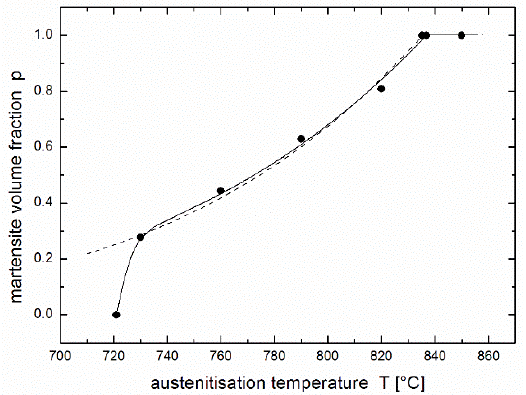
Figure 9. Dependence of equilibrium volume fraction of martensite (austenite) on austenitisation temperature fitted using Equation (12) (dashed line) and Equation (14) (full line). Both temperatures T min (835.3 and 836.8 °C) for p eq = 1 and Ac 1 = 721 °C for p eq = 0 are drawn as additional points.